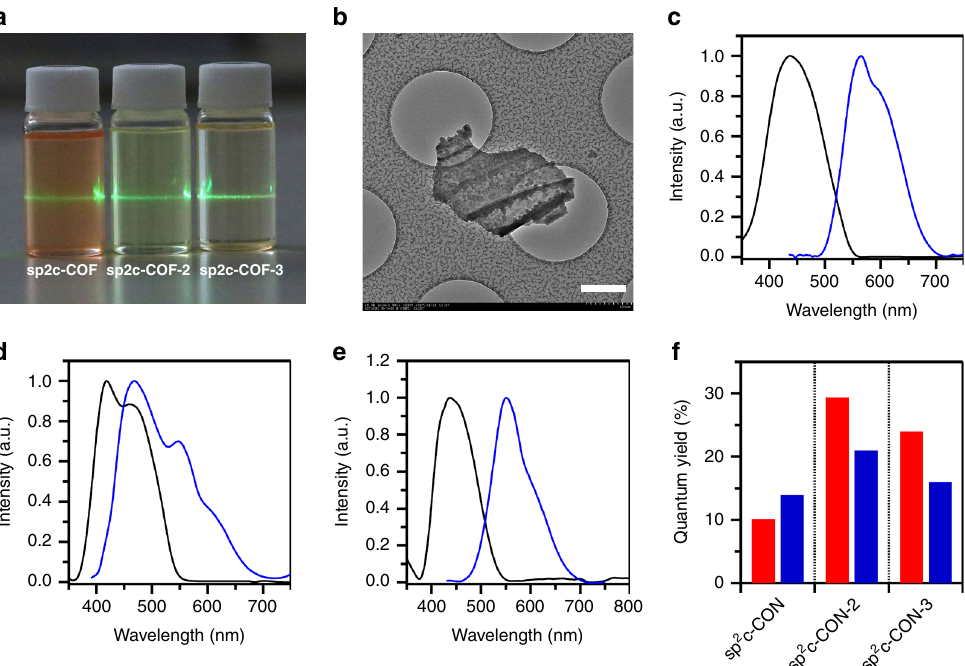
Fig. 6 Light-emitting properties of sp 2 c-CONs. a Images of Tyndall effect of sp 2 c-CONs after exfoliated in NMP. b HR-TEM image of sp 2 c-CON, scale bar 500 nm. c – e Electronic absorption (black curves) and fl uorescence spectra (red curves) of the thin fi lms of c sp 2 c-CON, d sp 2 c-CON-2, and e sp 2 c-CON-3. f Absolute fl uorescence quantum yields of sp 2 c-CONs in NMP (red bars) and thin fi lms (blue